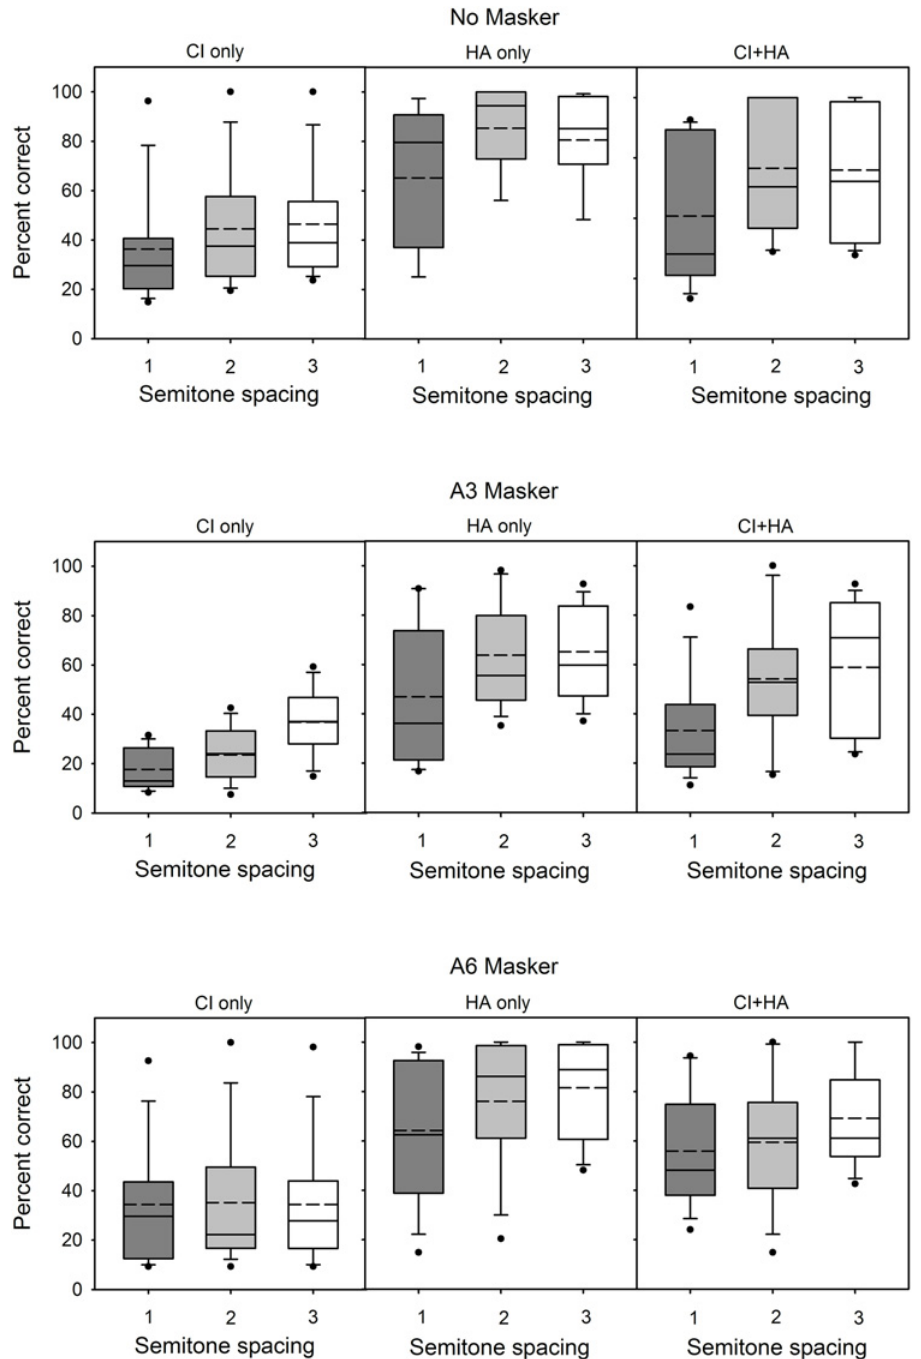
Fig 6. Boxplots of MCI performance as a function of semitone spacing, for the different listening and masker conditions. The columns indicate hearing device (CI, HA, and CI+HA) and the rows indicate masker condition (No Masker, A3 Masker, A6 Masker). The edges of the boxes represent the 25th and 75th percentiles, the solid line represents the median, the dashed line represents the mean, the error bars indicate the 10th and 90th percentiles, and the points outside of the error bars indicate